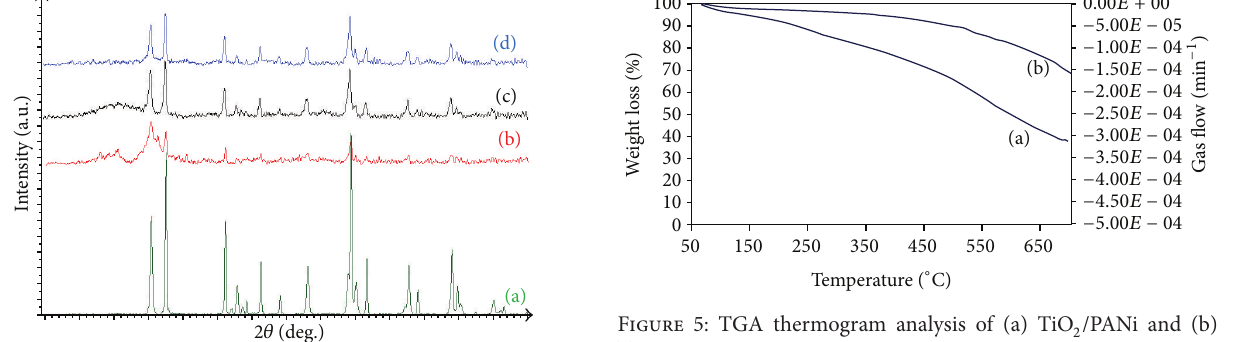
Figure 4: XRD patterns of samples. (a) TiO 2 particles, (b) TiO 2 /PANi, (c) TiO 2 /C, and (d) TiO 2 /AC, respectively.